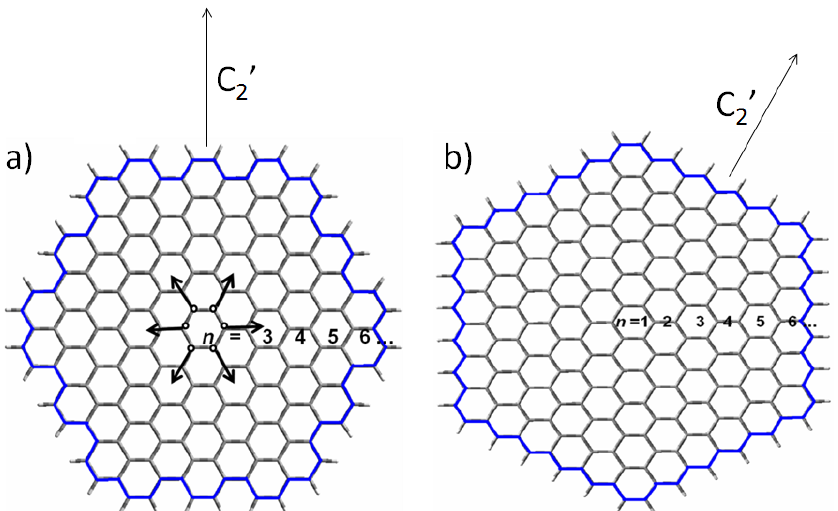
( b ) zigzag-graphene (6-Z-HGNS). The white balls denote hydrogen atoms terminating the edge carbon atoms, and the black balls represent carbon atoms. Both A- and Z-HGNS have point the D 6h